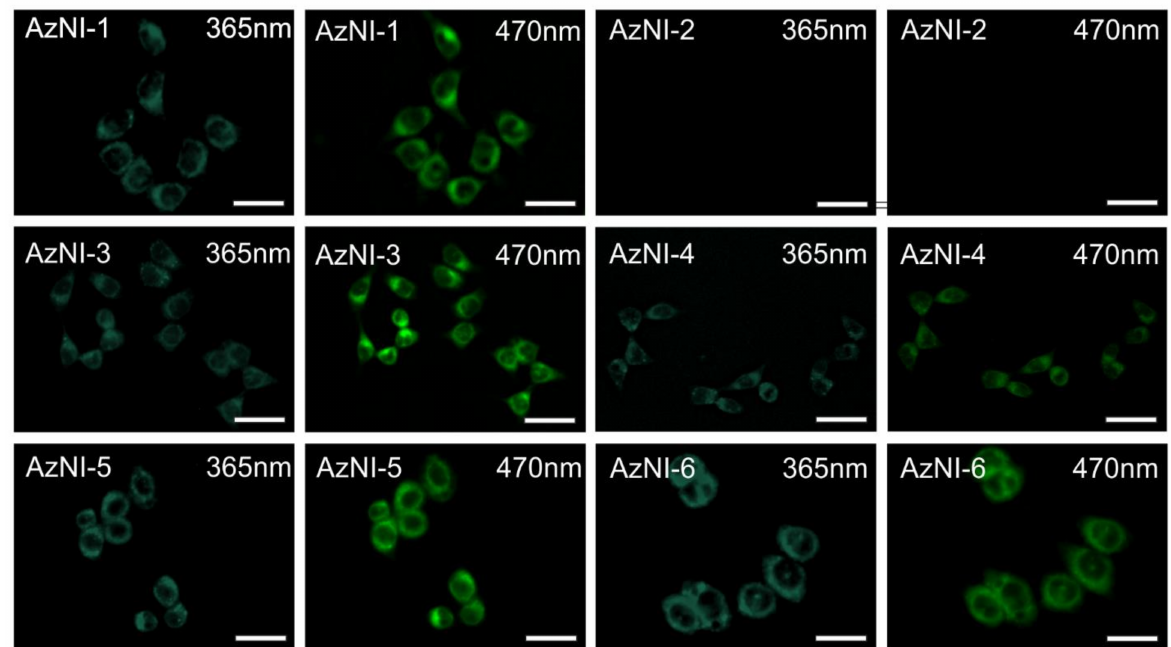
Figure 8. The fluorescence images of MCF-7 cells that were stained with the tested 1,8-napthalimide compounds (25 µ M) for 2 h. The images acquired under 365 and 470 nm LED illumination. Scale bars indicate 25 µ